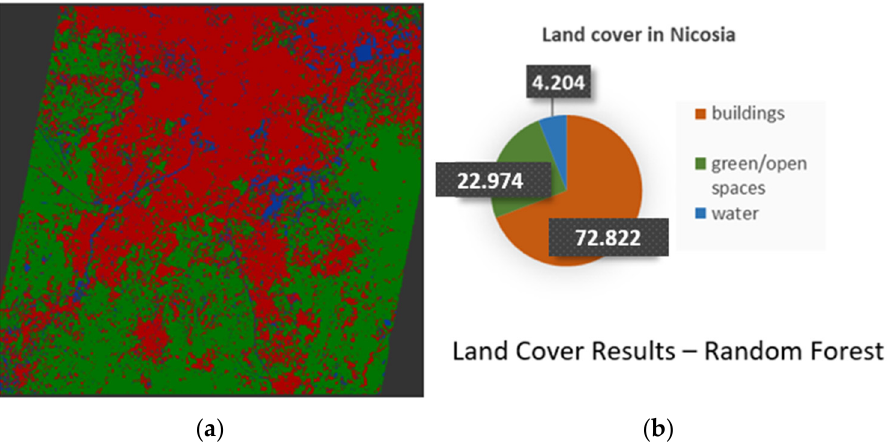
Figure 9. Classification Results in Nicosia from the synergetic use of SAR and optical data: ( a ) Random Forest output; ( b ) Land Cover.